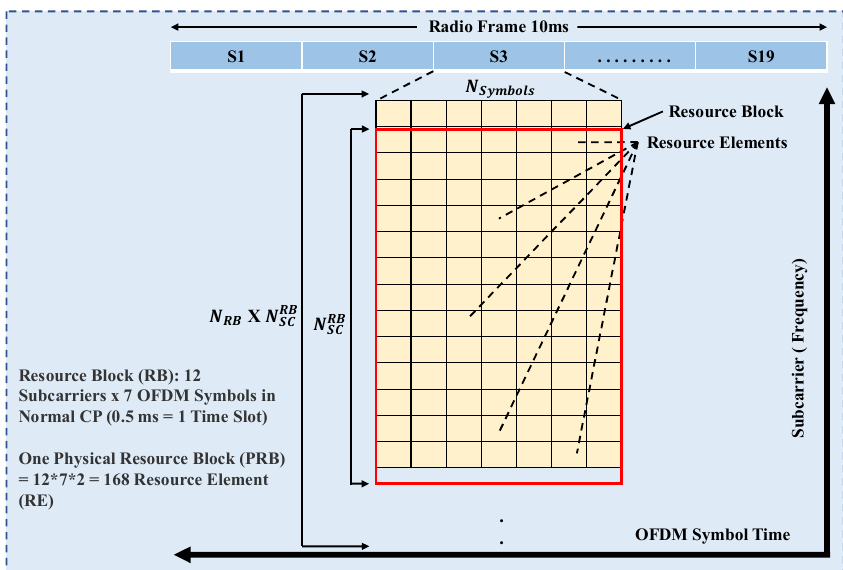
Figure 6. 5G radio resource